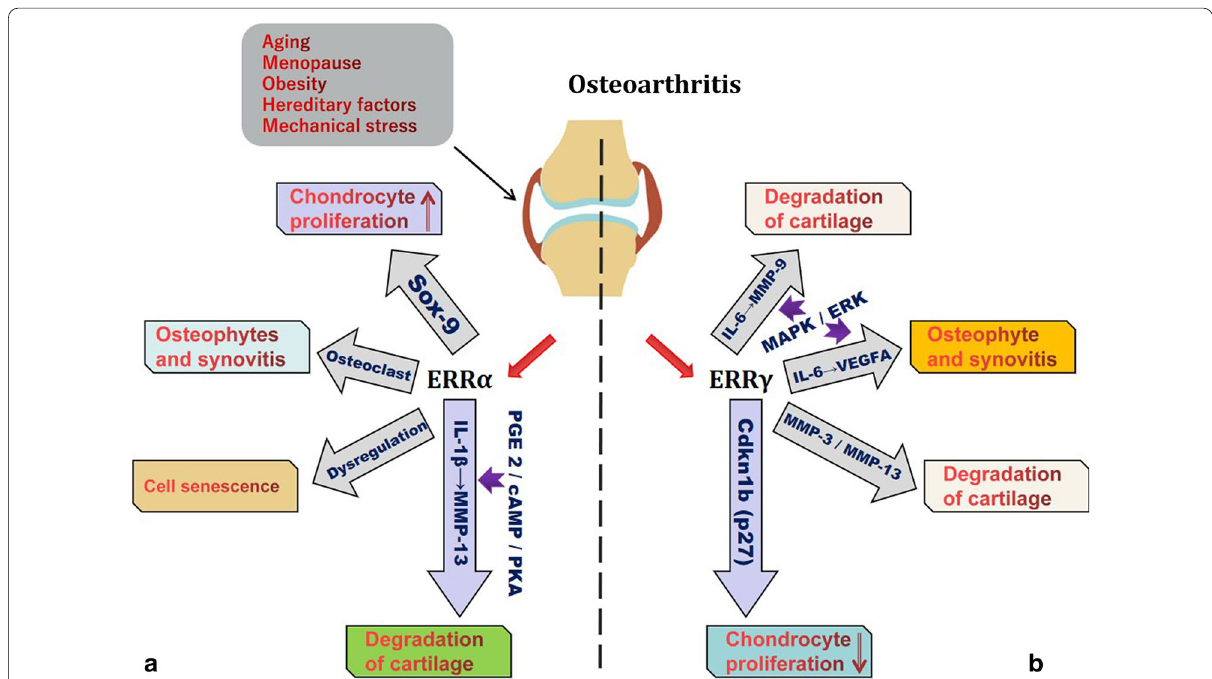
Fig. 2 When the joint is affected by pathogenic factors such as aging, menopause, obesity, hereditary factors, and mechanical stress, the expression of the ERR family becomes disordered. a ERRα promotes chondrocyte proliferation by upregulating Sox-9. ERRα is generated in response to IL-1β stimulation through the PGE2/cAMP/PKA signaling pathways and regulates MMP-13 production. The dysregulation of ERRα may affect the aging of chondrocytes. ERRα participates in osteophyte formation and synovial hyperplasia by impacting osteoclasts. b The overexpression of the ERRγ, as regulators of IL-6, VEGFA and MMPs, will inevitably result in the dysfunction of molecular substances, disrupt homeostasis, and induce osteophyte, synovitis and cartilage degradation. ERRγ also restrains chondrocyte proliferation by upregulating